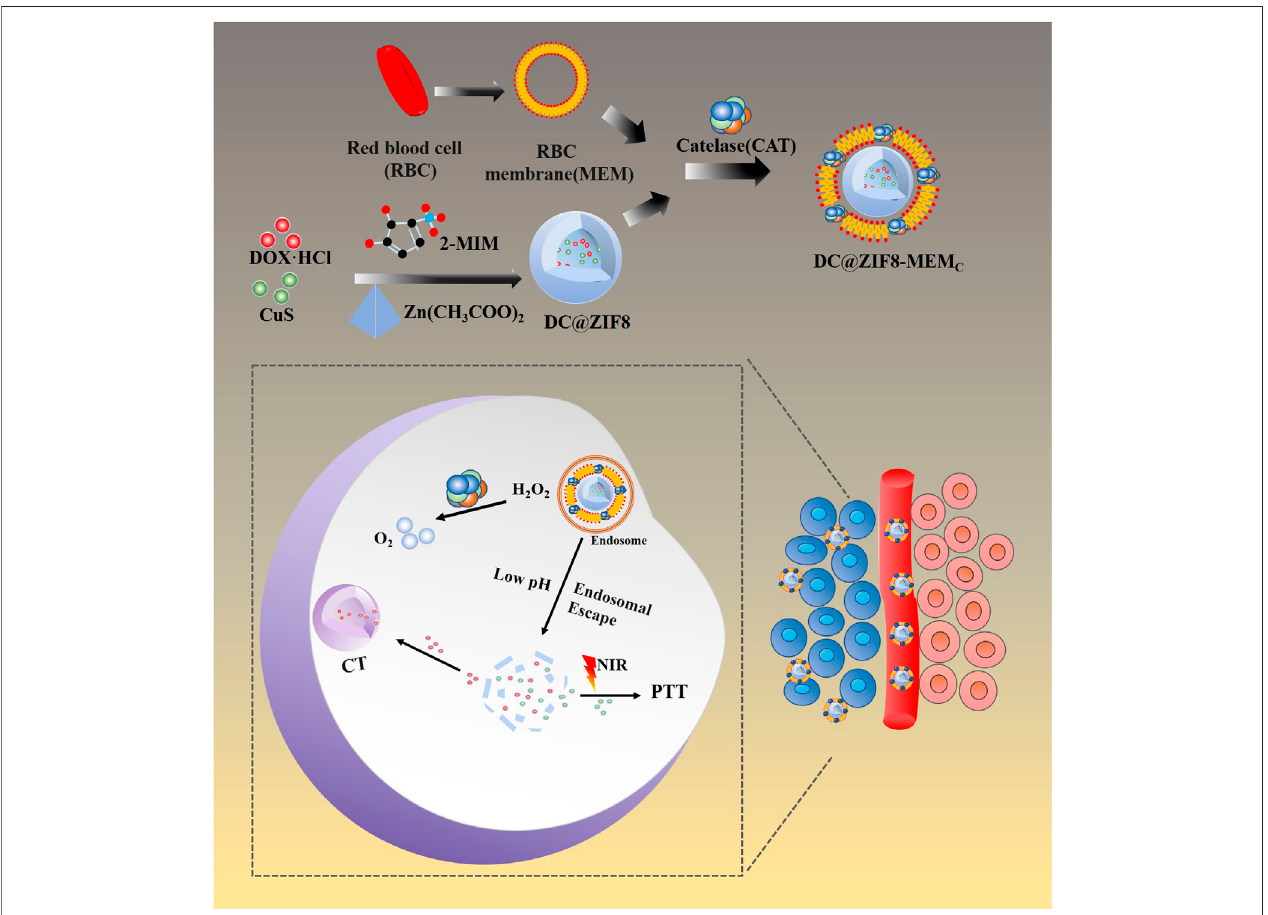
FIGURE 1 | Schematic illustration for the formation of DC@ZIF8-MEM C nanoplatform.